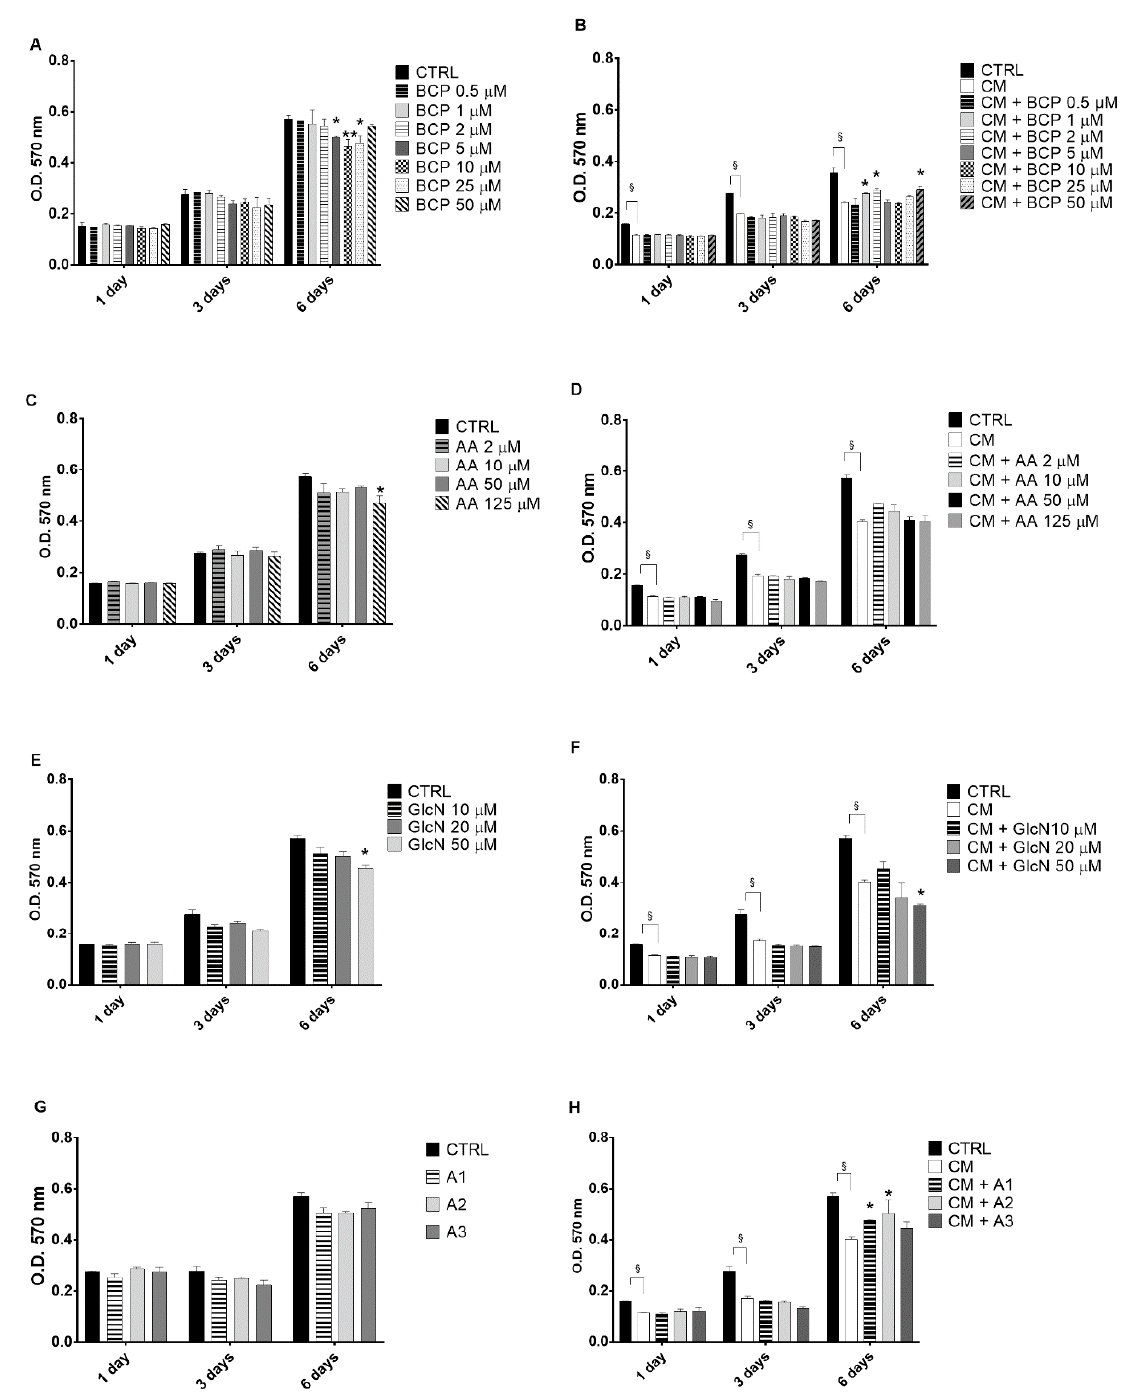
Figure 1. Time-dependent effects of BCP, AA and GlcN, alone or in combination, on human chondrocyte viability. Cells (7000/cm 2 ) were seeded in 96-well culture dishes exposed or not for 24 h to the conditioned medium (CM) of activated U937 and then treated at the indicated concentrations. ( A ) BCP; ( B ) BCP after CM exposure; ( C ) AA; ( D ) AA after CM exposure; ( E ) GlcN; ( F ) GlcN after CM exposure; ( G ) AA, GlcN and BCP mixture (A1, A2, A3); ( H ) AA, GlcN and BCP mixture (A1, A2, A3) after CM exposure. A1, 1 µM BCP, 2 µM AA and 10 µM GlcN; A2, 1 µM BCP, 10 µM AA and 20 µM GlcN; A3, 1 µM BCP, 50 µM AA and 20 µM GlcN. The MTT test was performed 1, 3 and 6 days after treatment. Data are reported as mean ± SE of three independent experiments. Statistical differences based on ANOVA test with multiple comparisons. CTRL: untreated cells; CM: cell treated with CM of activated U937 cells. * p < 0.05 and ** p ≤ 0.01 vs. CM-treated cells. § p < 0.05, CM-treated cells vs. untreated cells.